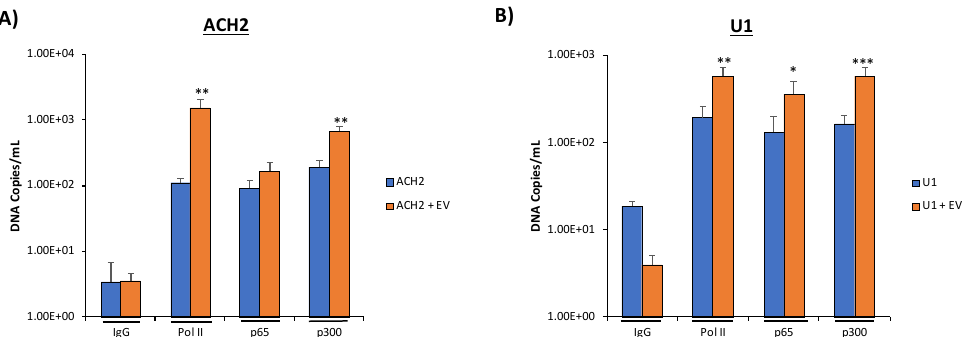
Figure 6. Presence of increased RNA Pol II and p300 on HIV-1 genome. CEM EVs were isolated using ultracentrifugation. ACH2 ( A ) and U1 ( B ) cells were then plated and treated with EVs at 1:5000. Cells were incubated for 24 h and again treated with CEM EVs at 1:5000. Following a second 24-hour incubation, cells were harvested and crosslinked prior to ChIP assay using antibodies against IgG, Pol II, p65, and p300. DNA was then quantified using PCR using NF- κ B1-2F and TAR + 59-R. IgG was used as a background control. A Student’s T-test was used to compare untreated control and EV- treated samples. *, p < 0.05; **, p < 0.01; ***, p < 0.001.